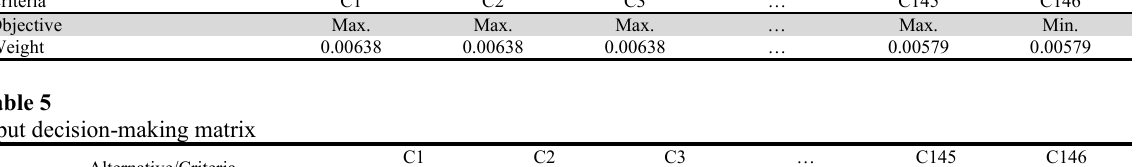
Information on the weighted criteria Criteria